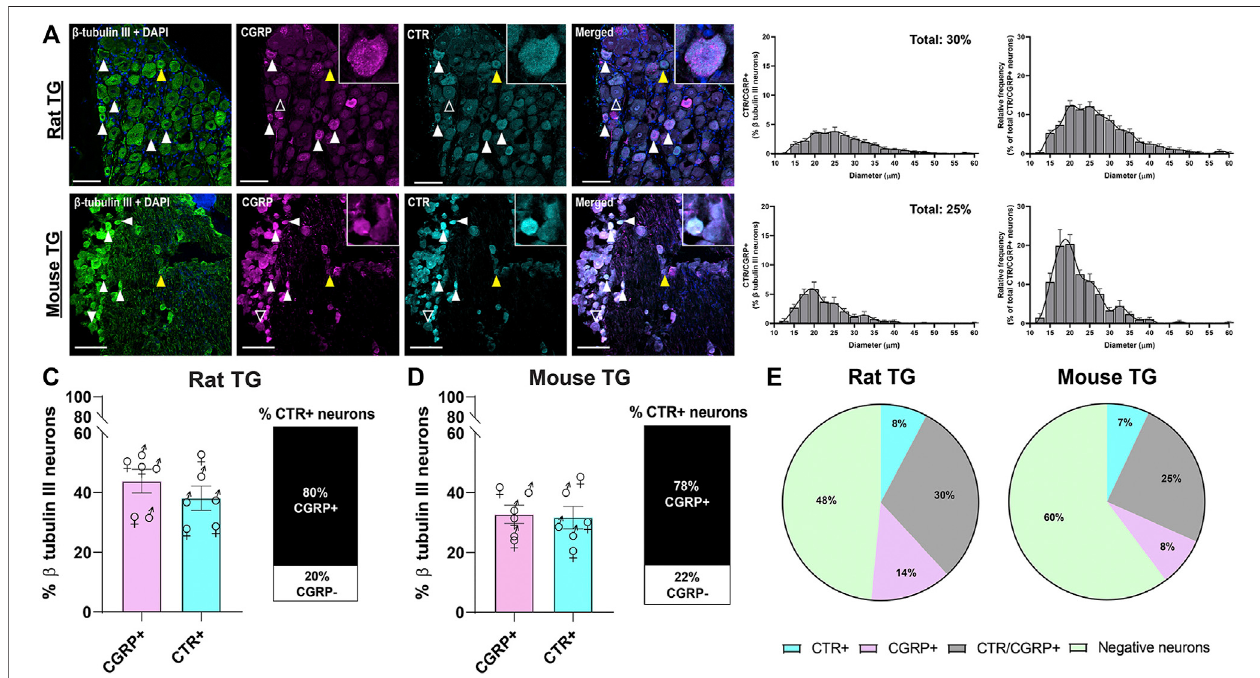
FIGURE 3 | Immunohistochemical localization and quanti fi cation of CGRP (pAb36001, 10 µg/ml) and of CTR (pAb188, 10 or 20 µg/ml) together with β tubulin III (2 µg/ml) in adult rat and mouse TG. (A) CGRP and CTR in rat and (B) CGRP and CTR in mouse. β tubulin III is shown for reference. Filled white arrowheads indicate examples of positive staining; empty arrowheads indicate examples of an absence of staining; yellow arrowheads indicate expression in adjacent neurons. Image brightnessand contrast wereadjustedforpresentation purposes and merged inFIJI. Scalebar =100 μ m.Imagesarerepresentativeofsixratsor mice (three male and three female). The size distribution (diameter) of neuronal cell bodies expressing CGRP and CTR for each species are displayed as histograms. The distribution of neuron size was quanti fi ed relative to the total β tubulin III (pan-neuronal marker) expressing neuron population and then relative to CTR/CGRP expression.